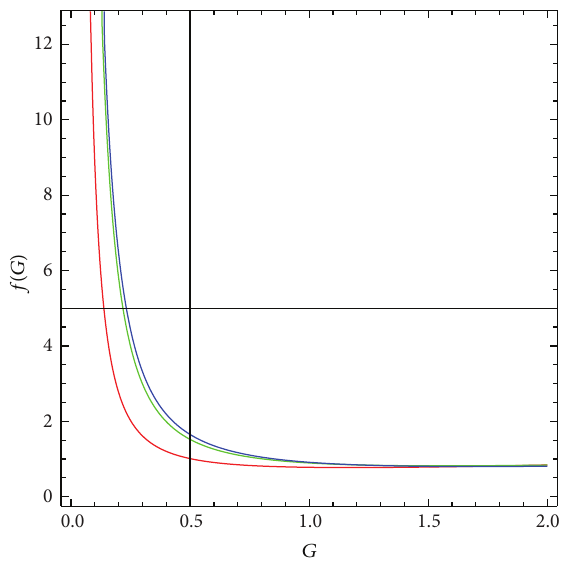
Figure 4: Plot of 𝑤 versus 𝑧 for PDE parameter 𝑢 = −2 with PDE 𝑚 = 2 (red), 𝑚 = 2.2 (green), and 𝑚 = 2.4 (blue).